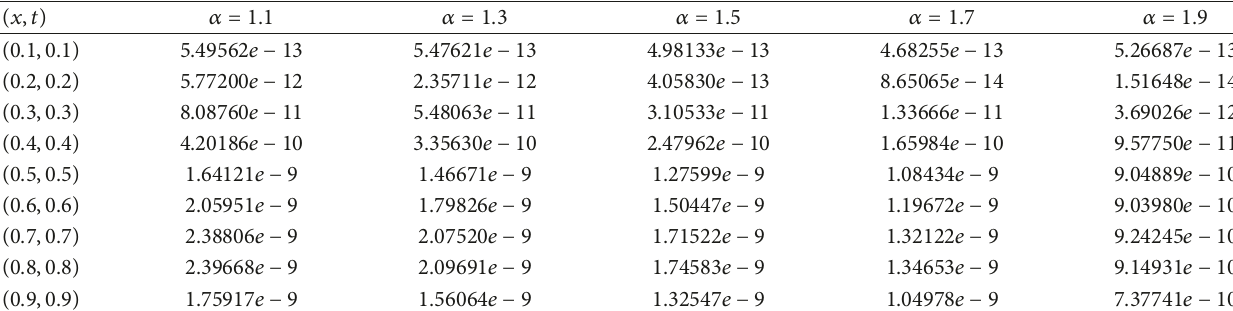
Table 6: The absolute error for Example 3 for some different values 1 < 𝛼 ≤ 2 at some different points.